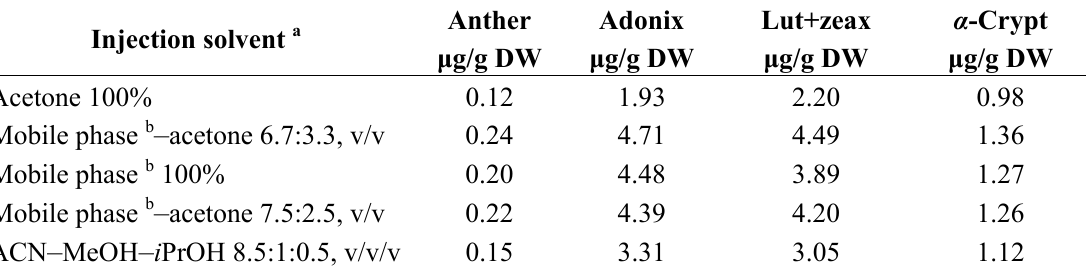
Table 3. Effect of the injection solvent on the determination of the final carotenoid content of transgenic maize. A homogeneous lyophilized maize sample (TM1) was used for all